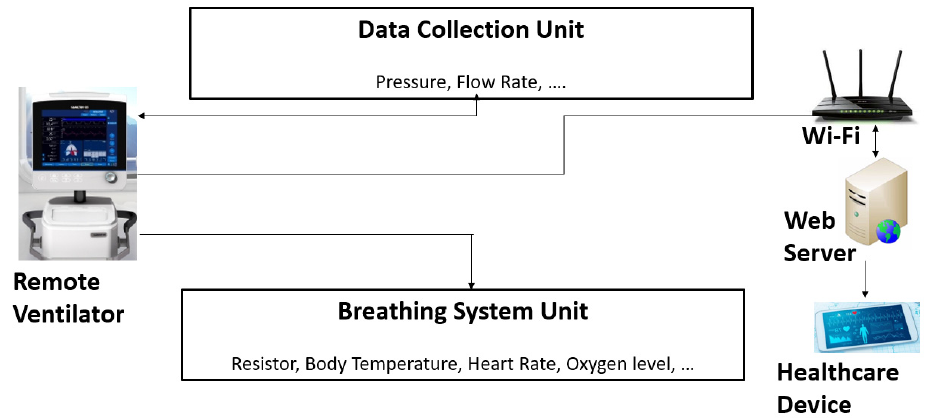
Figure 1. Remote ventilator system model.